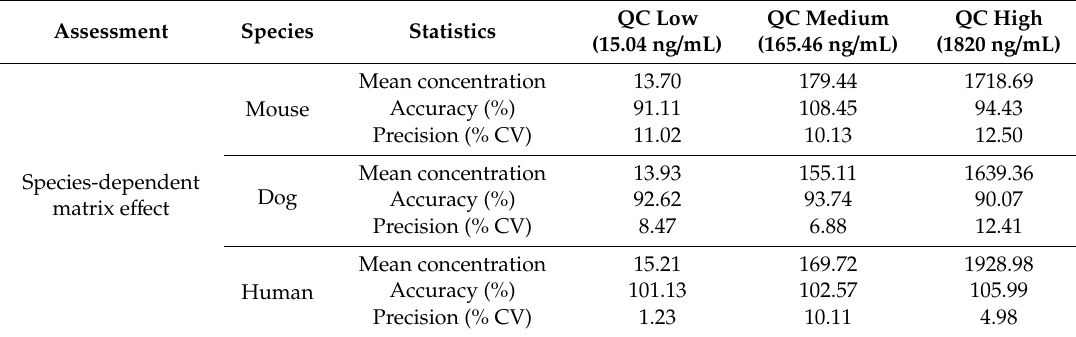
Table 4. Various species-dependent matrix e ff ects in mouse, dog and human plasma ( n =